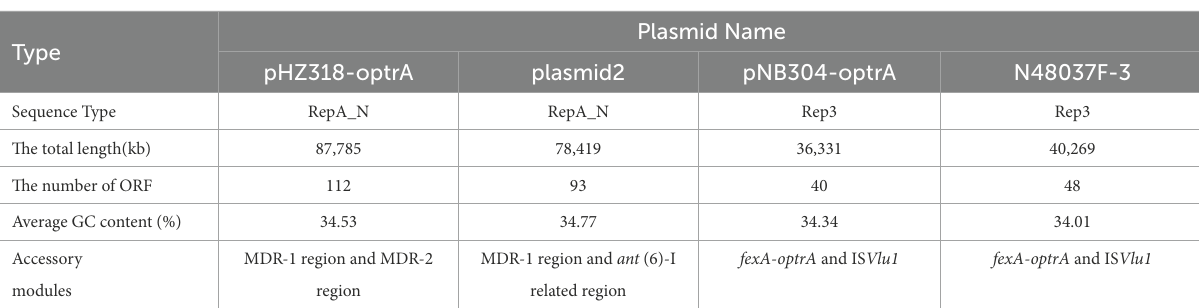
TABLE 2 Major features of plasmids analyzed.